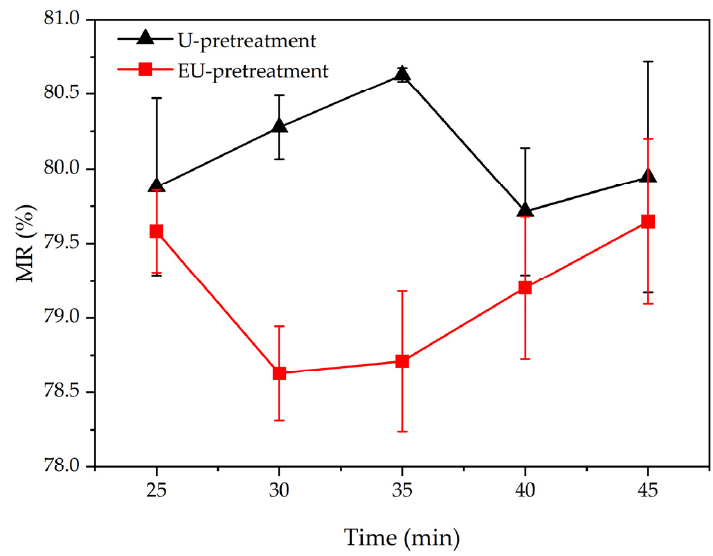
Figure 3. Effect of pretreatment time on moisture of Ginkgo fruits.